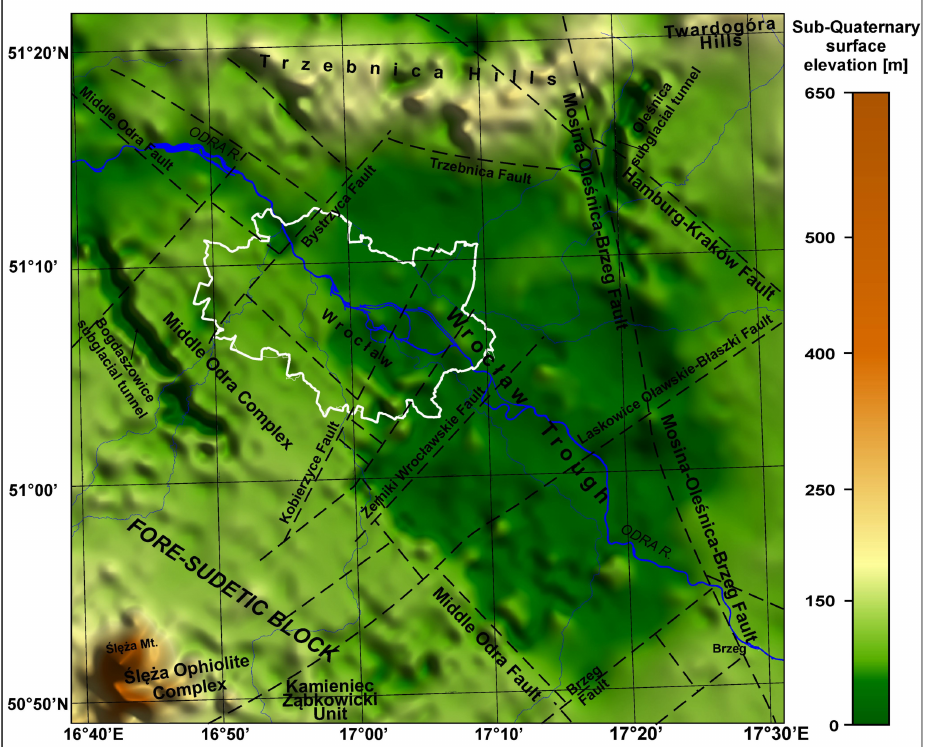
Figure 1. Location of the research area.